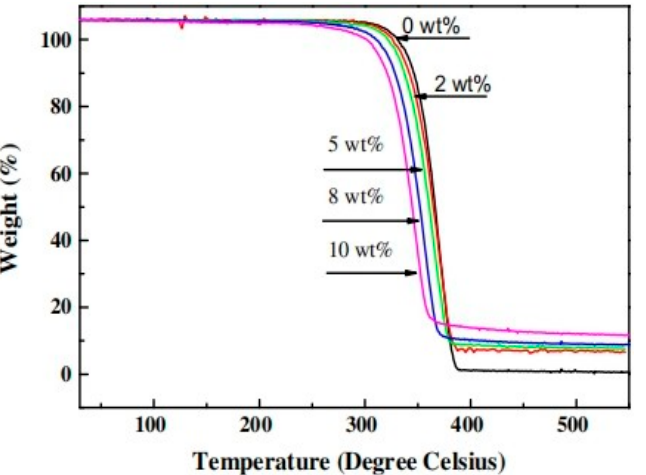
Figure 8. Thermogravimetric curves as a function of temperature of pure PLA and CFF/PLA composites. (Reproduced with a copyright permission from Cheng et al. [133]).